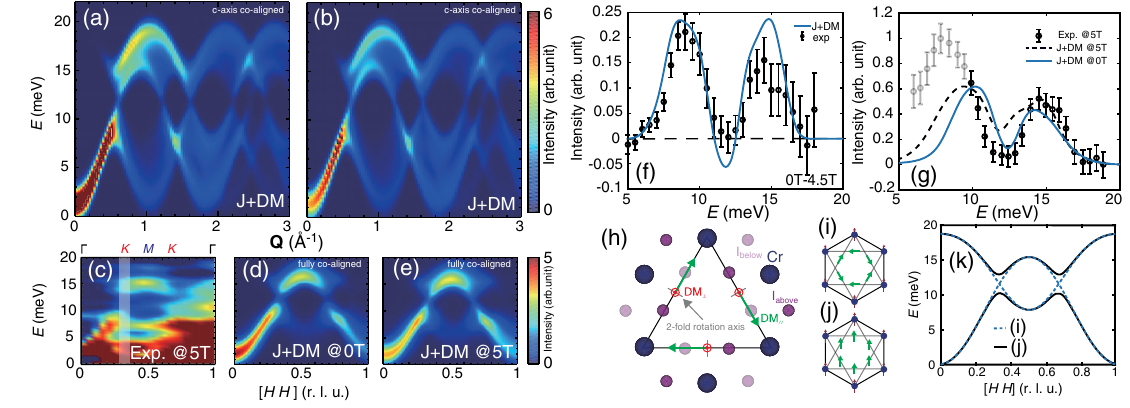
FIG. 6. The magnetic field effect on the Heisenberg-DM model. (a, b) Calculated E - Q spectra of c axis aligned CrI 3 using the Heisenberg-DM Hamiltonian with 0 and 4.5 T in-plane fields, respectively. (c) Spin waves of a fully co-aligned CrI 3 single crystals near the Dirac point along the [ H , H ] direction with a 5 T in-plane magnetic field. (d, e) Heisenberg-DM model simulation with 0 and 5 T in- plane field, respectively. (f) The effect of a magnetic field on spin wave dispersion near Dirac point and its comparison with the Heisenberg-DM calculations. (g) Constant- Q cut at the Dirac point ( ½ H; H (cid:3) ¼ ð 0 . 3 ; 0 . 37 Þ ) on the experimental data and Monte Carlo simulations. The experimental data has a constant background subtracted. The gray dots show intensity increasing due to higher instrumental background. (h) Schematics of the in-plane DM interaction of a triangular sublattice in one Cr hexagon. The in-plane component of the DM interaction (DM ) is perpendicular to the two-fold rotation axis between the two NN Cr ions according to the k Moriya s rule. (i) In-plane DM interactions respecting the three-fold symmetry of the lattice. (j) An example of in-plane DM interactions breaking the three-fold symmetry of the lattice. (k) The calculation of spin wave dispersion with in-plane spins and in-plane DM interactions shown in red dashed lines (i) and black solid lines (j). Here DM ¼ 0 . 17 meV. k